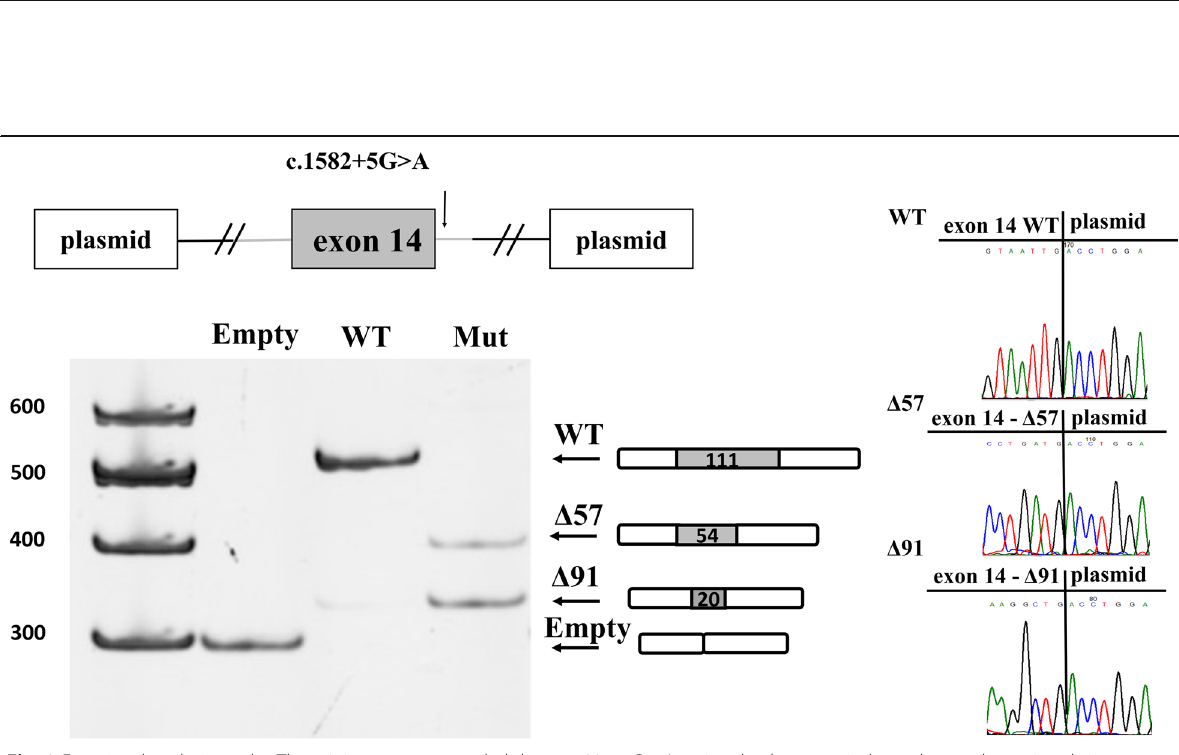
Fig. 2 Functional analysis results. The minigene assay revealed that c.1582 + 5G > A variant leads to two independent pathogenic splicing alteration: a 57 ( Δ 57) and a 91 ( Δ 91) nucleotide truncation. On the top schematic minigene design is depicted. WT- wild type, Mut- mutation. The uncropped version of the gel image is available as additional file